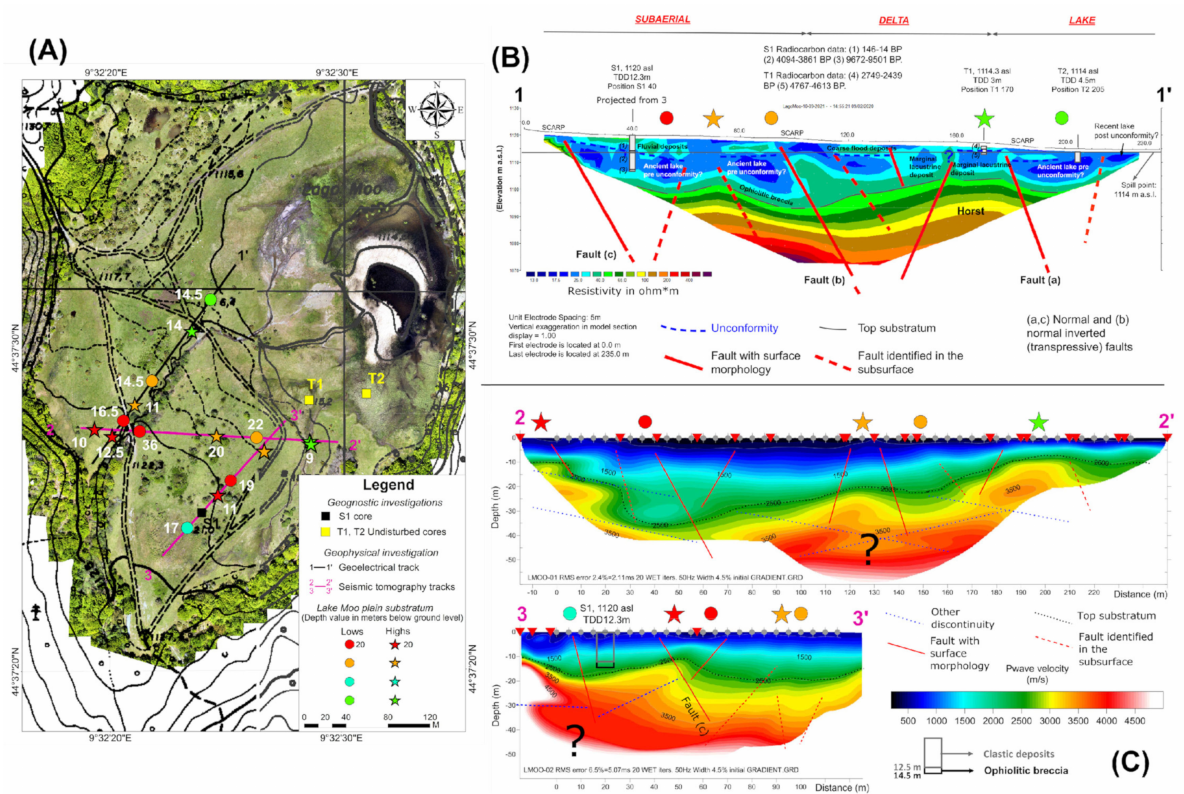
Figure 8. ( A ) Location of the geophysical profiles shown in ( B , C ) with labeling of the correlated structural highs and lows of the ophiolitic substrate. ( B ) Geoelectrical resistivity tomography and interpretation. The depth of the unconformity is in accordance with the spill point altitude of Lake Moo (1114 m a.s.l.). ( C ) Vp seismic tomography profiles (modified from [10], © Author(s) 2020, Creative Commons Attribution 4.0 License; https://cp.copernicus.org/articles/16/1547/2020/cp-16 -1547-2020-supplement.pdf, accessed on 11 April 2022), and interpretation. Question marks outline areas with ambiguous and/or unclear